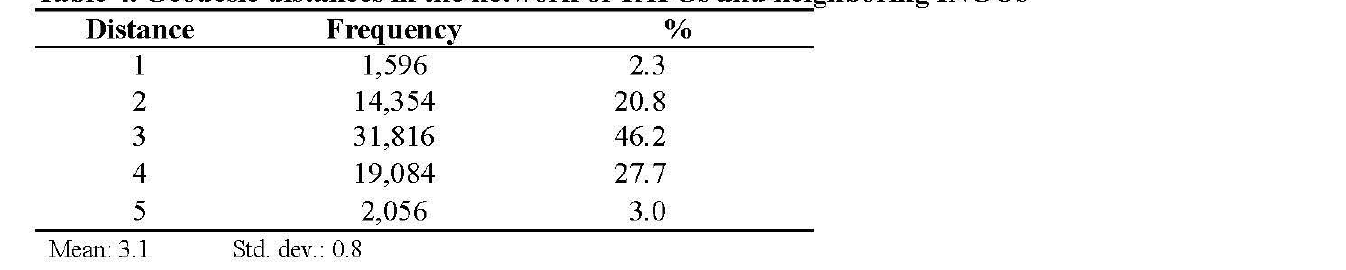
Table 4. Geodesic distances in the network ofTAPGs and neighboring INGOs